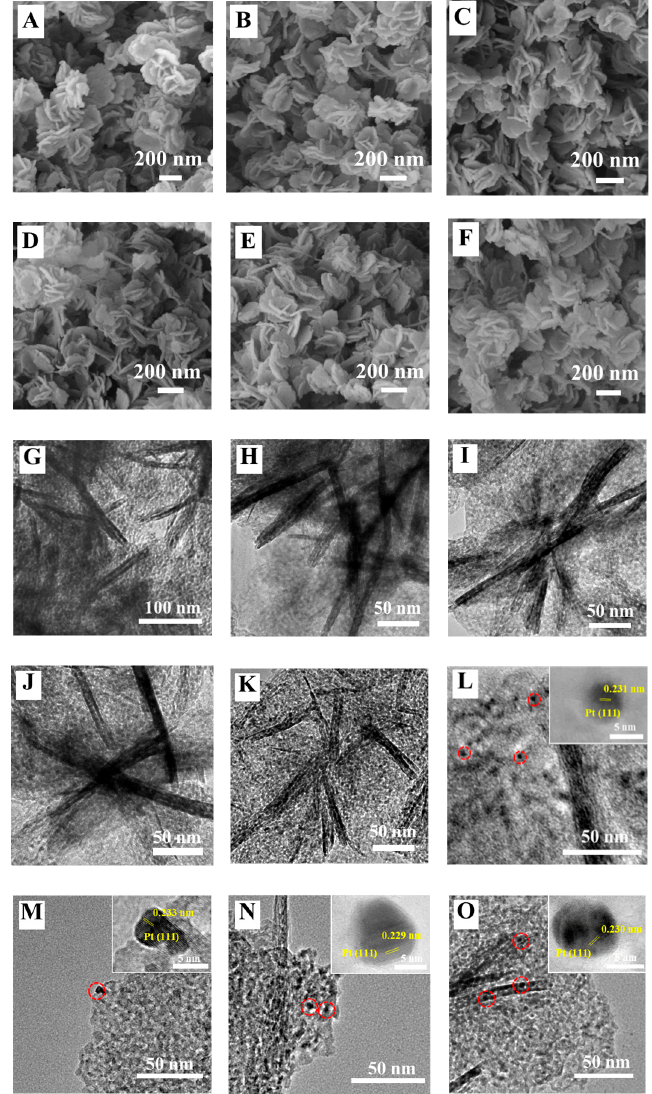
Figure 5. SEM ( A – F ) and TEM ( G – O ) images of Pt n /Ni 1.5 Co 0.5 AlO catalysts: ( A ) Ni 1.5 Co 0.5 Al-LDH; LDH; ( B , G ) Ni 1.5 Co 0.5 AlO; ( C , H , L ) Pt 1 /Ni 1.5 Co 0.5 AlO; ( D , I , M ) Pt 2 /Ni 1.5 Co 0.5 AlO; ( E , J , N ) ( B , G ) Ni 1.5 Co 0.5 AlO; ( C , H , L ) Pt 1 /Ni 1.5 Co 0.5 AlO; ( D , I ,M) Pt 2 /Ni 1.5 Co 0.5 AlO; (E, J , N ) Pt 4 /Ni 1.5 Co 0.5 AlO; ( F , K ,O) Pt 6 /Ni 1.5 Co 0.5 AlO. Pt 4 /Ni 1.5 Co 0.5 AlO; ( F , K , O ) Pt 6 /Ni 1.5 Co 0.5